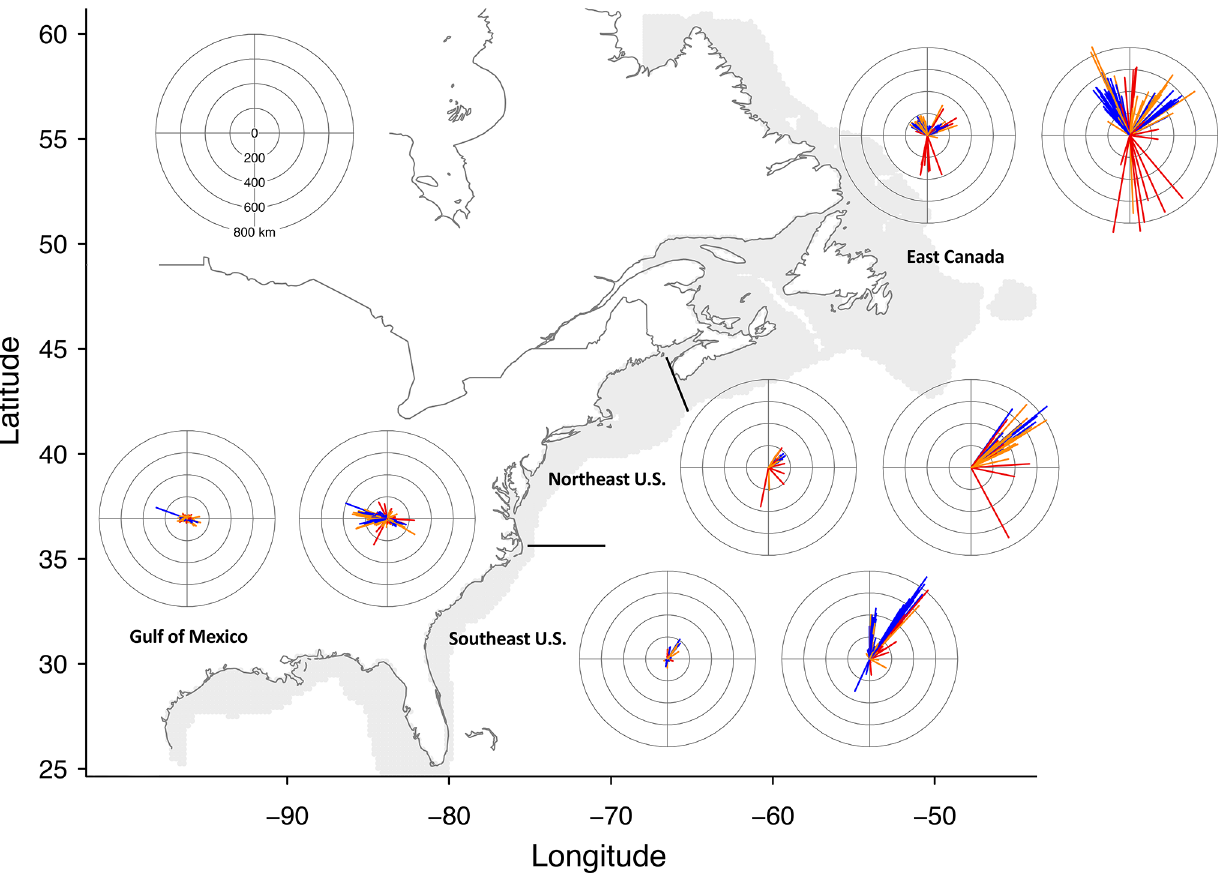
Fig 4. Projected shifts in distribution for east coast species. The direction and magnitude in km of projected shifts in centroids for 336 species on the North American east coast and 239 species in the Gulf of Mexico. For additional detail refer to Fig 3 caption. Note that the scale of the compass plots for the east and west coasts